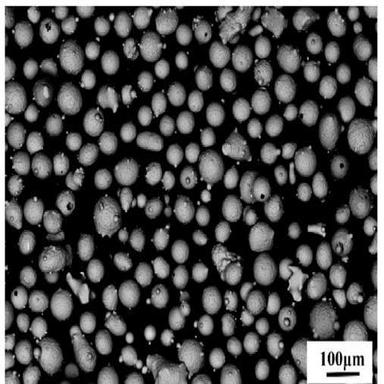
SEM image of pre-alloyed powder.